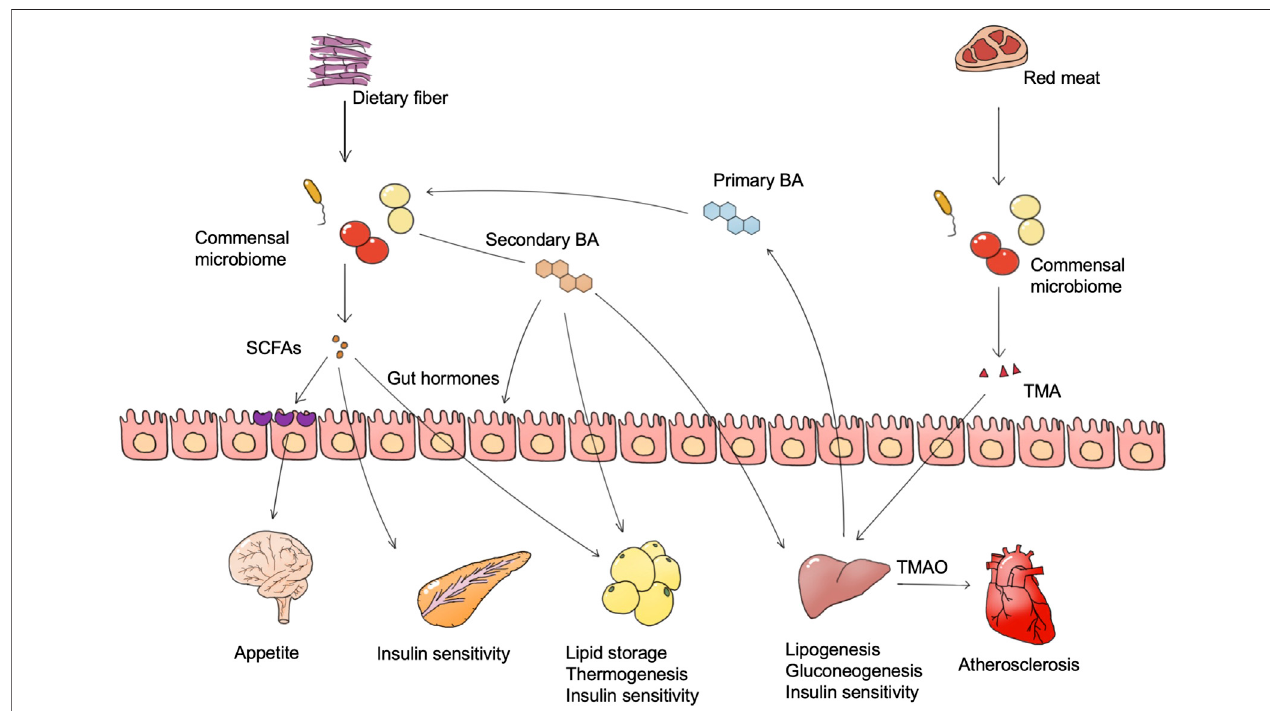
FIGURE 1 | Microbiome-derived metabolites and metabolic diseases. Foods such as dietary fi ber and red meat are degraded by the microbiome to generate multiple bioactive substances, ofwhich SCFAs and TMAO are widely con fi rmed as important. The microbiomealso converts host bile acids into more complex bile acid species. These microbiome-derived metabolites regulate the metabolism pathway in different tissues, and are fi nally involved in metabolic abnormalities of metabolic diseases. Abbreviations: SCFAs, short-chain fatty acids. BA, bile acid. TMA, trimethylamine. TMAO, trimethylamine oxide.